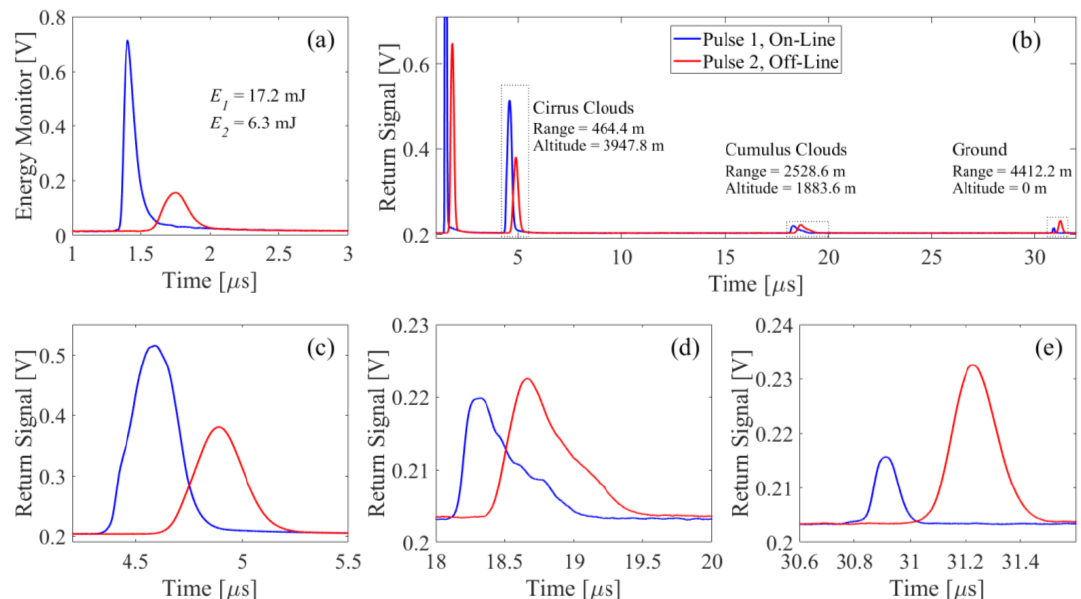
Figure 12. Sample of the 2- µ m IPDA lidar signal profiles collected during airborne operation on 17 September 2019 at 6:8:27 local time. ( a ) IPDA lidar transmitted energy monitor signals and ( b ) corresponding return signals obtained using e-APD detection channel, applied for CO 2 remote sensing. Return profiles capture three distinctive features, as shown in the zoom-in for ( c ) Cirrus clouds, ( d ) Cumulus clouds and ( e ) ground. These represent the IPDA raw data processed by 10-sec (500) shot average obtained using 2-GHz on-line setting and 3 V e-APD bias voltage.